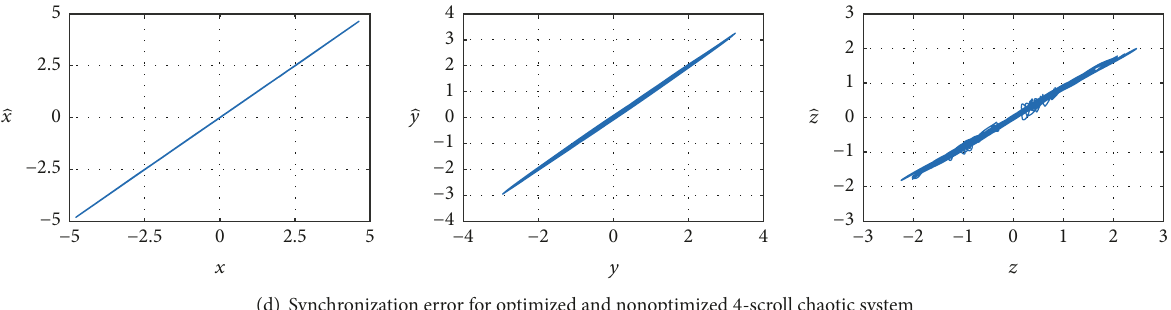
synchronization gains 𝑘1 = 4, 𝑘2 = 20, 𝑘3 = 45 , and initial conditions ic = 2.99, −0.03, 0.1 . On the other hand, for slave system traditional values 𝑎 = 0.7 , 𝑏 = 0.7 , 𝑐 = 0.7 , = 0.7 are considered; also a symmetrical SNLF with slopes 𝑑 1 = 200 and delays ℎ = −2, 0, 2 are used, ic = 2.9, 0.01, 0.01 . Figure 14 shows the simulation results of synchronization.